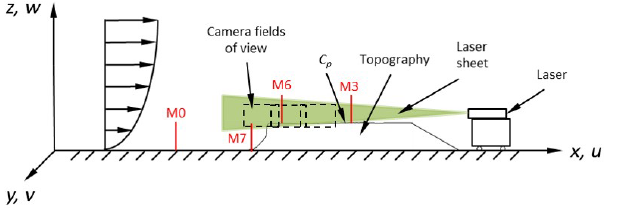
Figure 1. Schematic of WindEEE experimental setup.